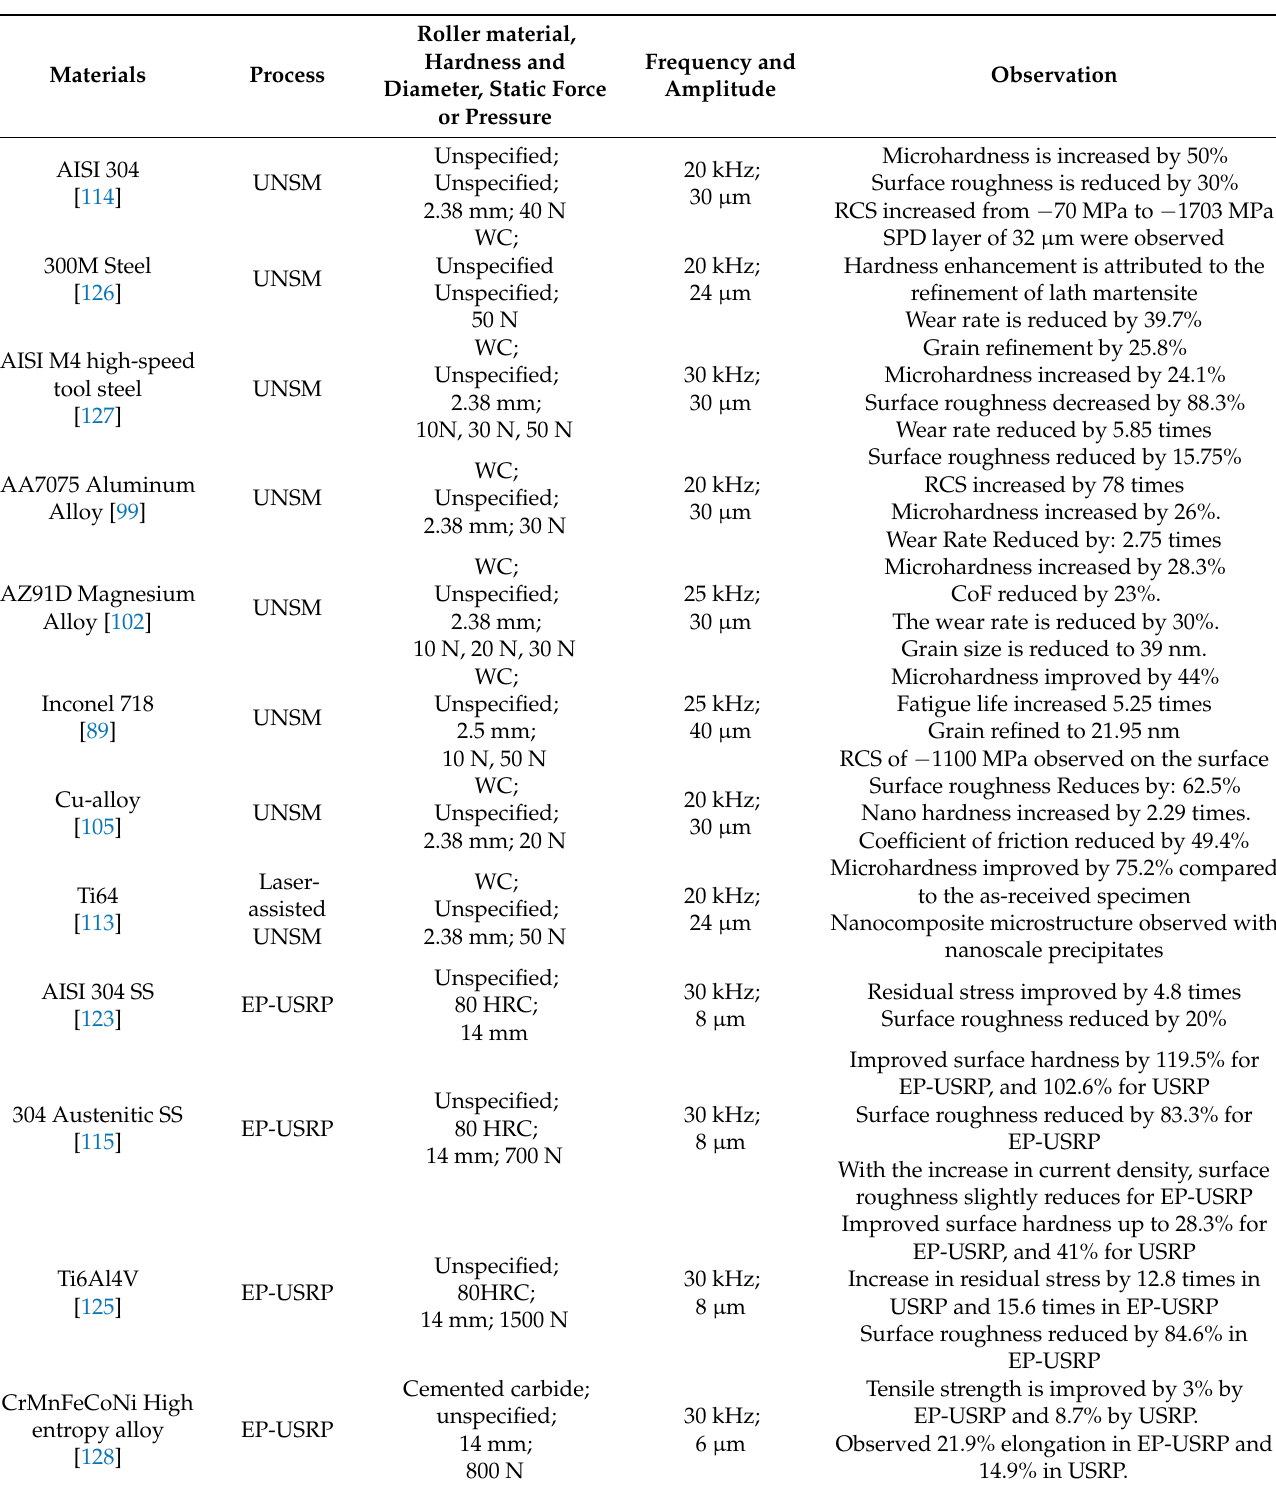
Table 2. Recent advancement of